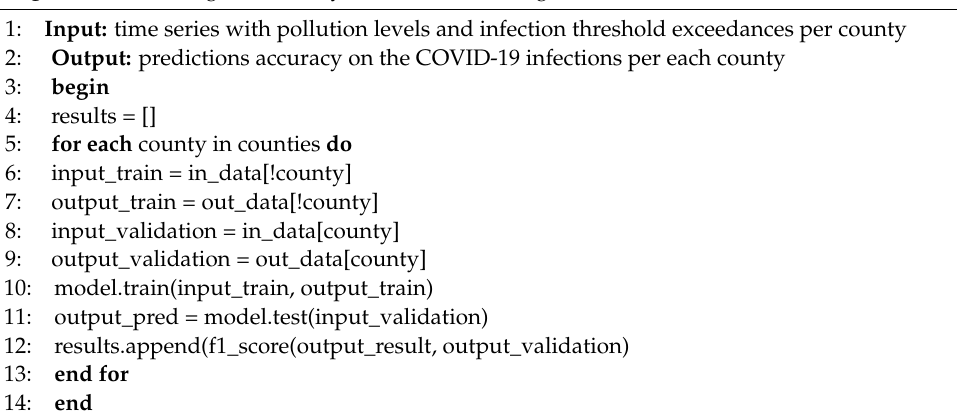
Algorithm 2 Training and (county) cross validation